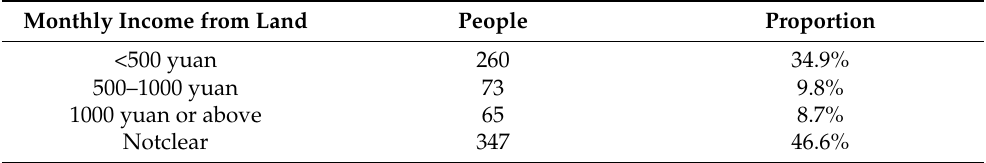
Table 6. Monthly land income of elderly people in rural villages. Monthly Income from Land